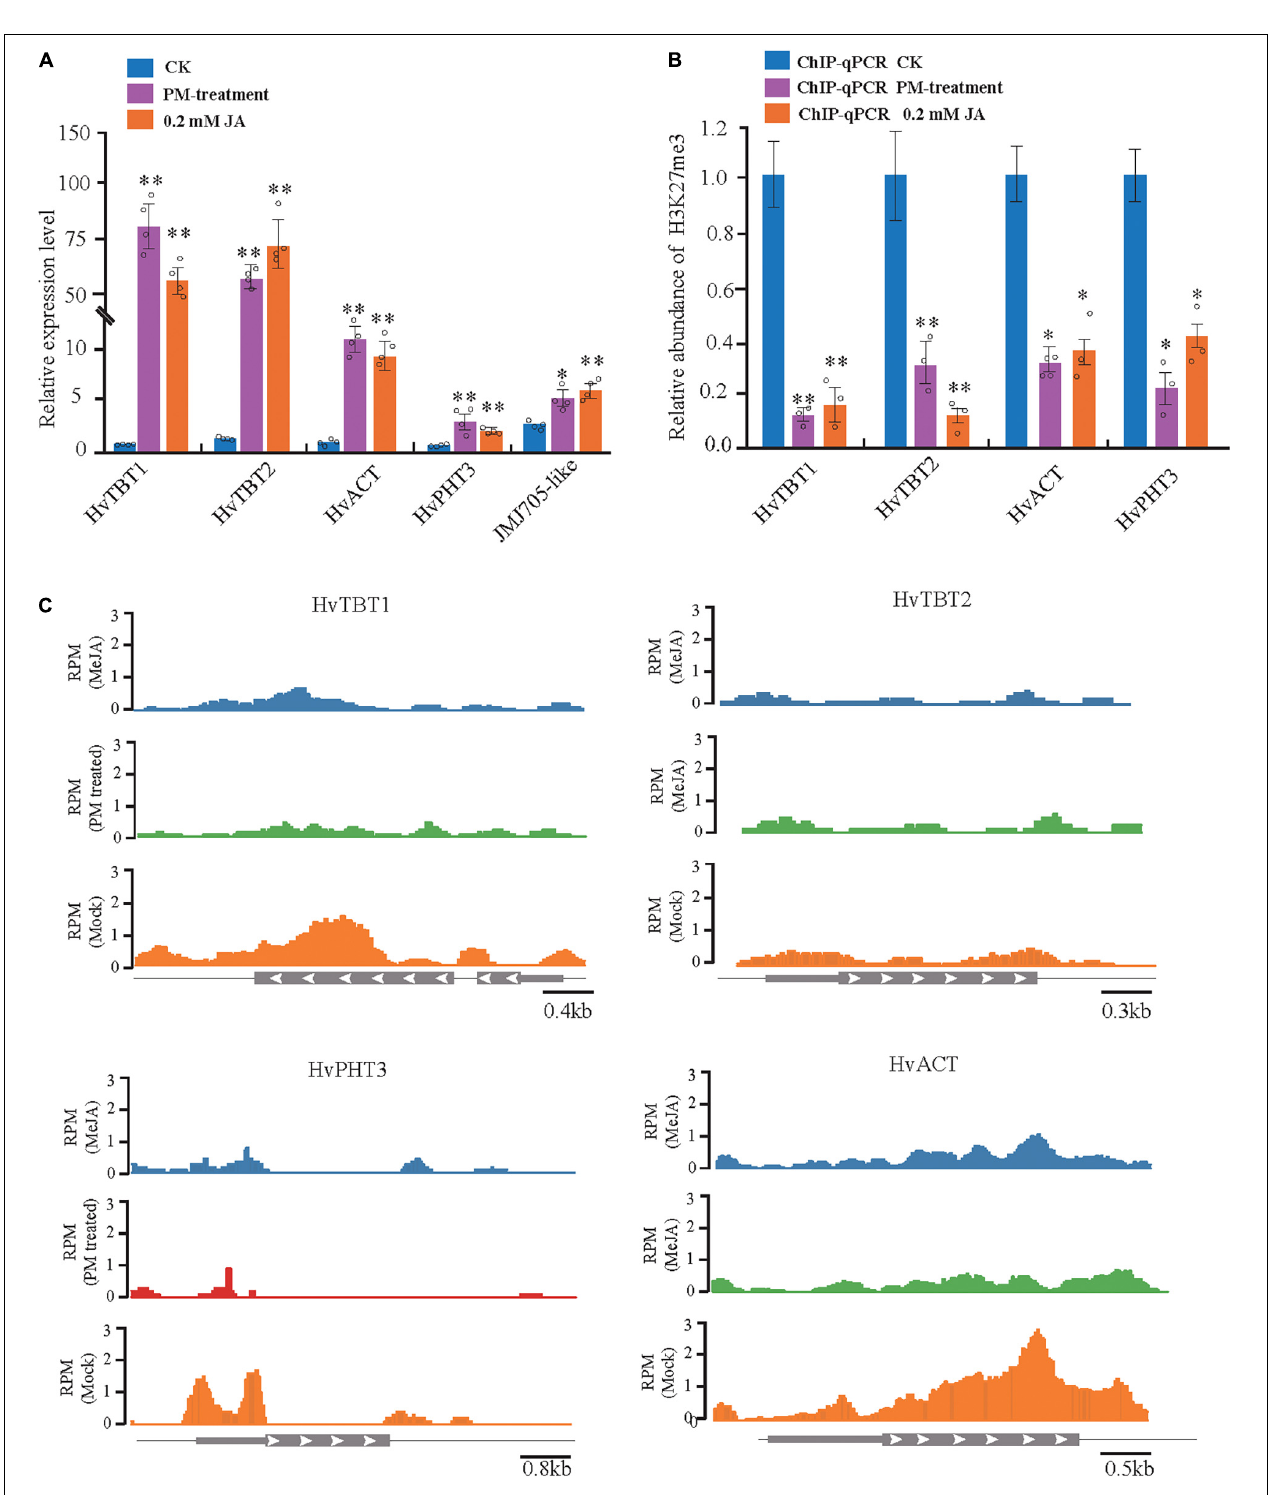
FIGURE 7 | Analysis of MeJA-mediated (or PM-treated) regulation of the four N -acyltransferases. (A) The expression level of the four N -acyltransferases and JMJ705- like under control, powdery mildew (PM) and MeJA-treated plants. The expression values are represented as mean ± SD ( n = 3). (B) H3K27me3 ChIP assays of the four JA- responsible N -acyltransferases treated with PM for 6 h and MeJA for 24 h. (C) H3K27me3 ChIP-on-chip data of the four JA-responsible N -acyltransferases in response to PM and MeJA treatment. Schematic representation of the gene structure. ∗ P < 0.05, ∗∗ P < 0.001 by unpaired two-tailed Student’s t